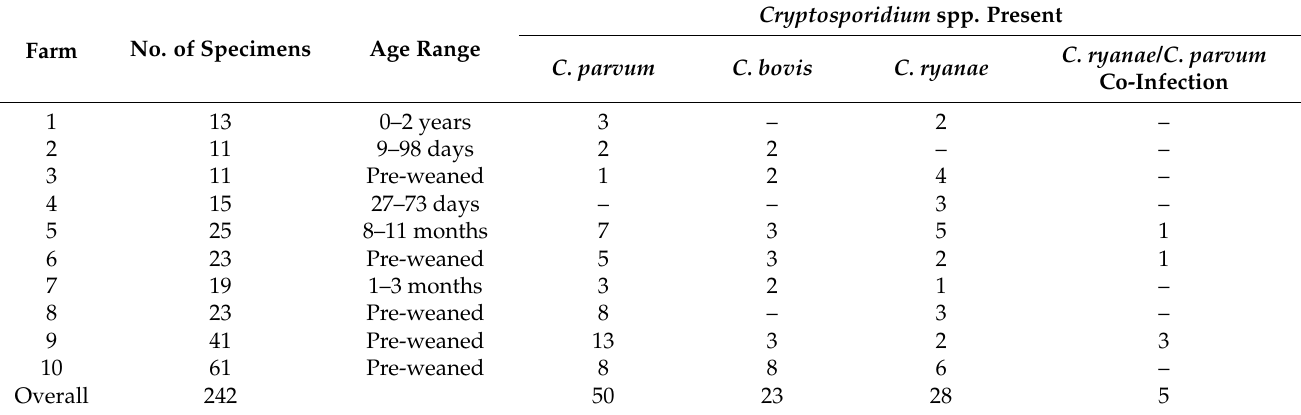
Table 1. Cryptosporidium spp. prevalence in Cypriot dairy